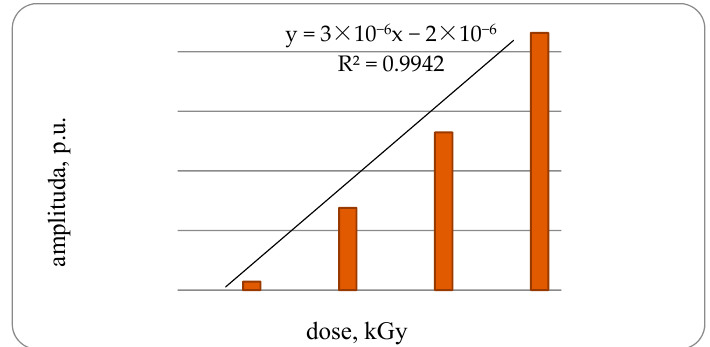
Figure 2. Amplitude of Electron Paramagnetic Resonance (EPR) signals samples of bone tissue of rainbow-cooled trout irradiated with different doses.